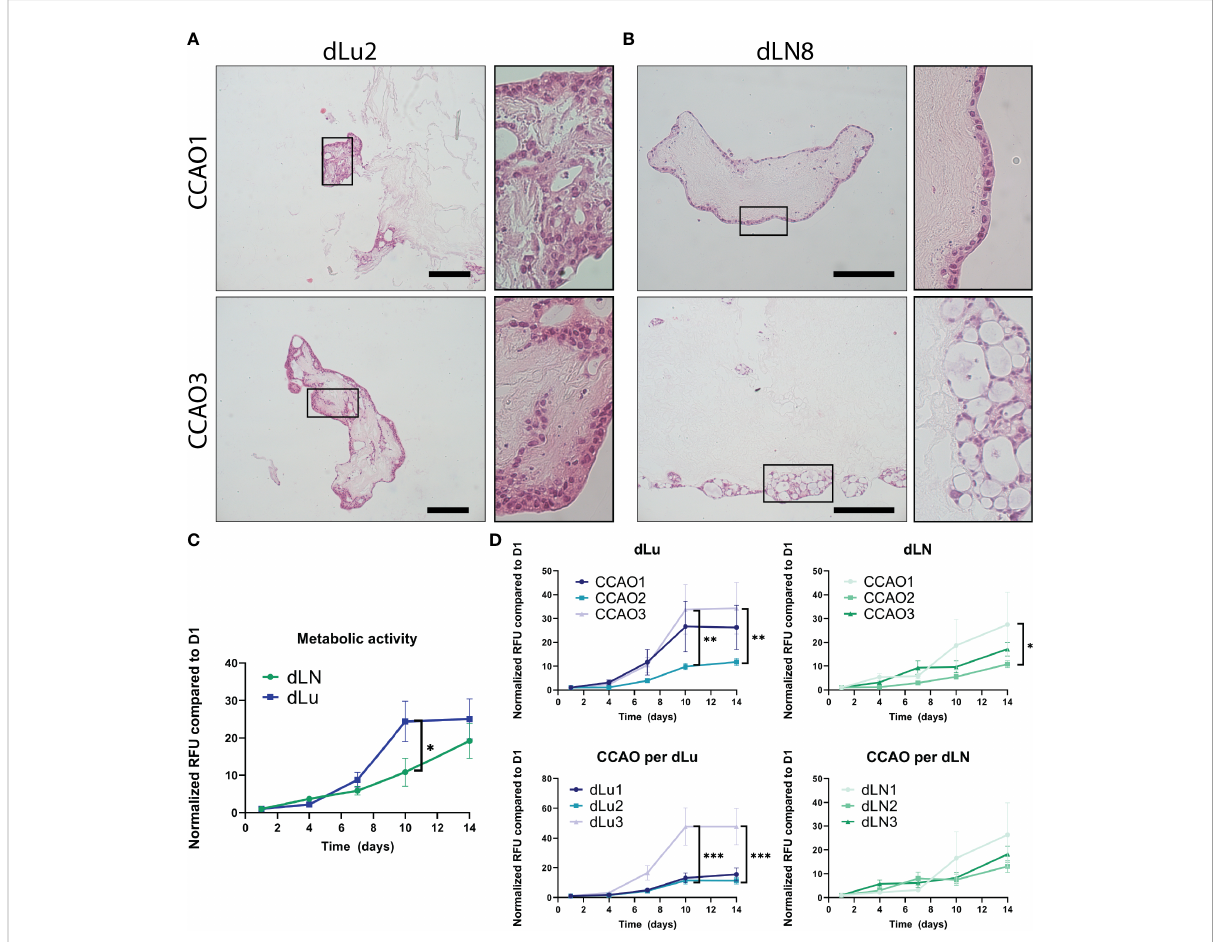
FIGURE 6 Proliferation and migration dynamics of metastasis in CCAOs. (A, B) Representative H&E stainings of CCAO1 (top) and CCAO3 (bottom) in dLu (A) and dLN (B) . The black rectangle shows a higher magni fi cation image of the morphology of the CCAOs in the decellularized scaffolds. Scale bars indicate 250 µ m. (C) Metabolic activity measurements of recellularized dLN (n=27, n=3 ECM donors with n=3 CCAO lines and n=3 technical replicates per combination) and dLu (n=27, n=3 ECM donors with n=3 CCAO lines and n=3 technical replicates per combination) consecutively measured on day 1, 4, 7, 10, and 14. All Relative Fluorescent Units (RFU) data is normalized to day 1. (D) Metabolic activity measurements for CCAOs in dLU split based on patient origin of CCAO (i.e. separated CCAO1, CCAO2, and CCAO3) and donor of decellularized scaffolds (i.e. separated dLu1, dLu2, and dLu3). (E) Metabolic activity measurements for CCAOs in dLU split based on patient origin of CCAO (i.e. separated CCAO1, CCAO2, and CCAO3) and donor of decellularized scaffolds (i.e. separated dLN1, dLN2, and dLN3). * = p-value<0.05, ** =